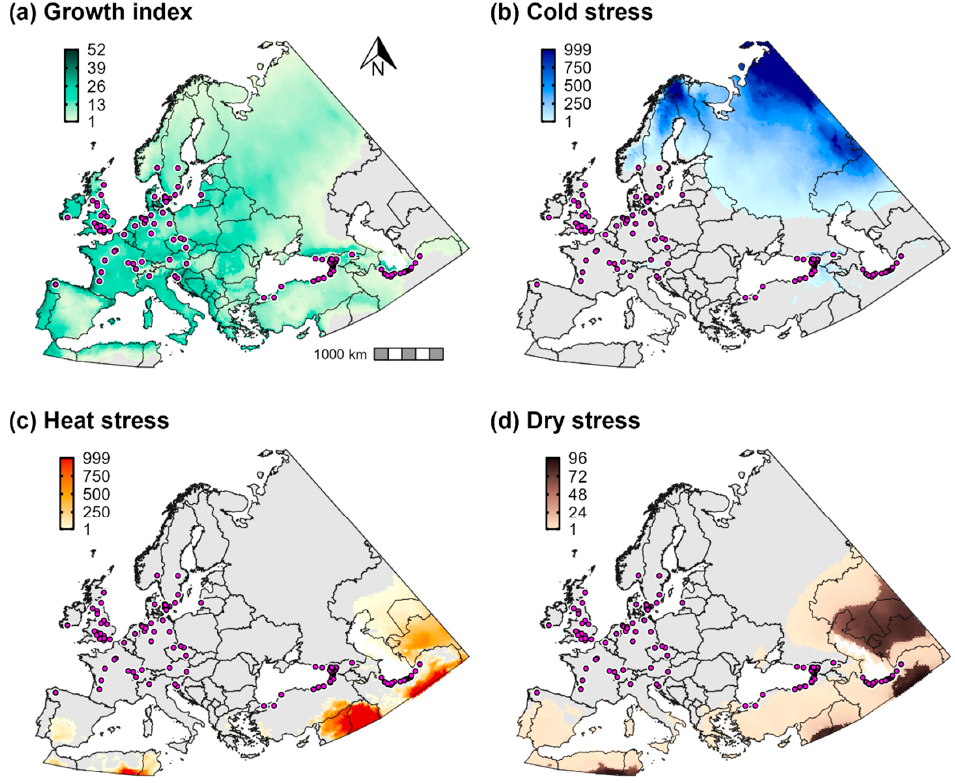
Figure 3. Population growth and climate stress accumulation for Calonectria pseudonaviculata in Europe and western Asia. Population growth in CLIMEX is measured as the ( a ) annual growth index (range = 0–100). Climate stress indices (range = 0–999) include ( b ) cold stress, ( c ) heat stress, and ( d ) dry stress. Pink circles depict the approximate locations of all presence records for the region.